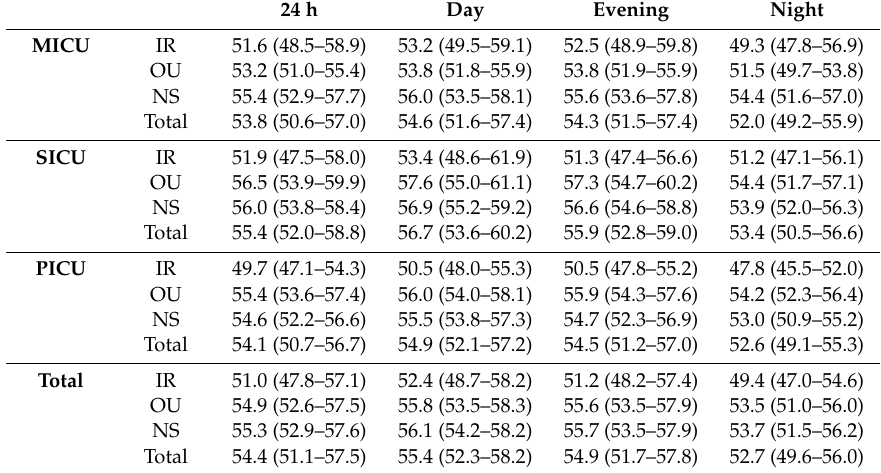
Table 1. Median (IQR) noise exposure levels (dBA) according to each ICU and time schedule.